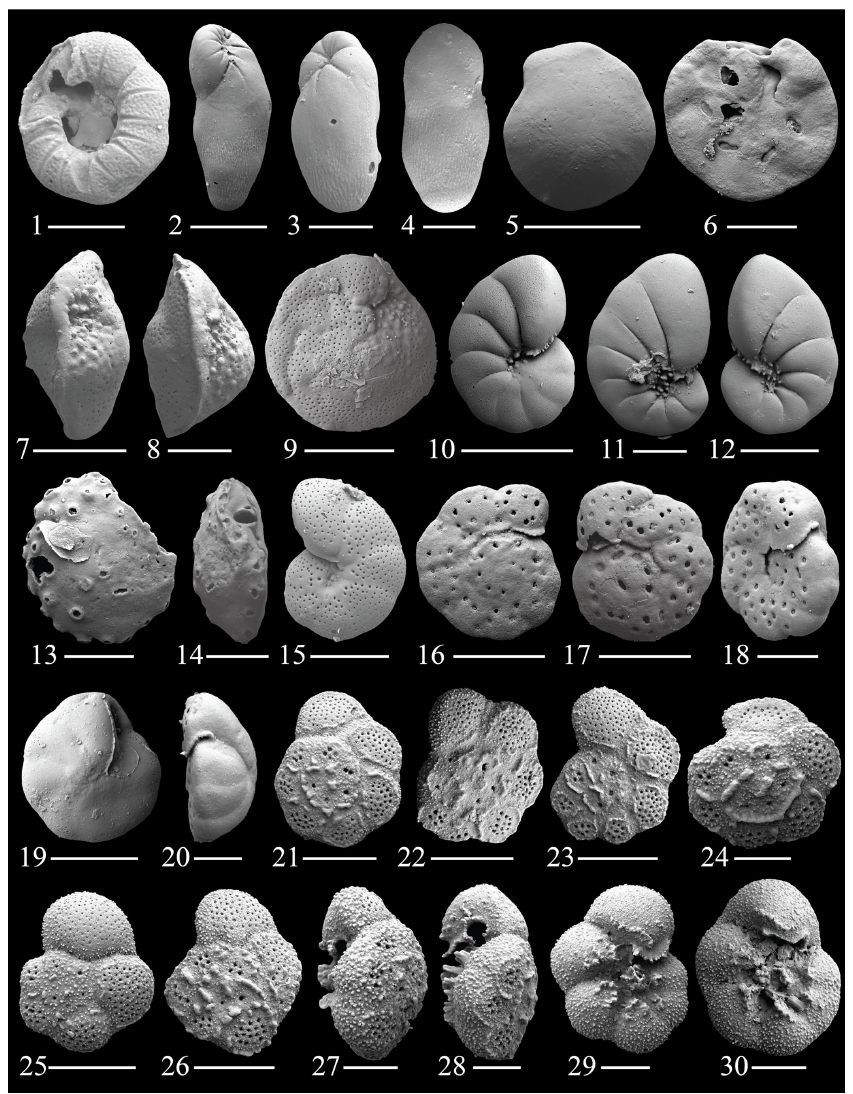
Figure 8. (1) Glabratella mirabilis Seiglie and Bermúdez; (2–4) Elongobula parallela (Cushman and Parker); (5–6) Eoponidella pul- chella (Parker); (7–8) Amphistegina lessonii (d’Orbingy); (9) Amphistegina radiata (Fichtel and Moll); (10–12) Nonionides grateloupii (d’Orbingy); (13–14) Svratkina acuta (Sidebottom); (15) Anomalinulla glabrata (Cushman); (16–20) Anomalinulla sp. 1.; (21–30) Pararo- talia cananeiaensis Debenay, Duleba, Bonetti De Melo e Souza & Eichler. The scale bar is 100 and 50µm for figs. (1) , (3) – (4) , (6) – (9)